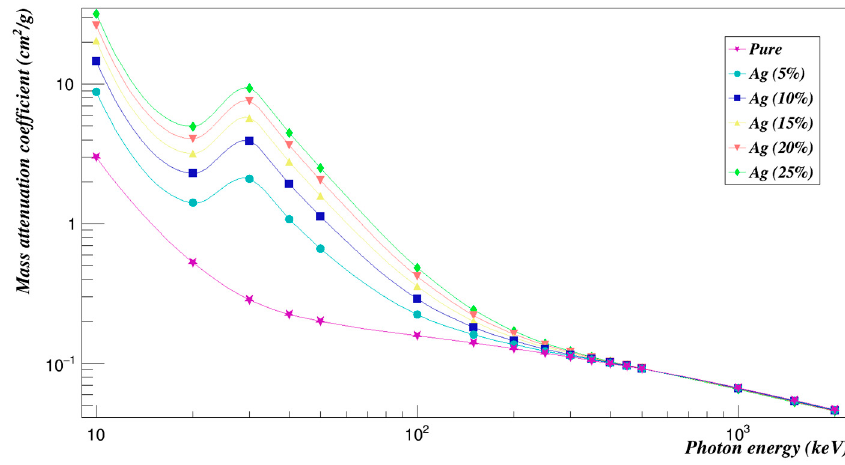
Figure 12. Photon mass attenuation coefficients of Polyimide doped with silver.